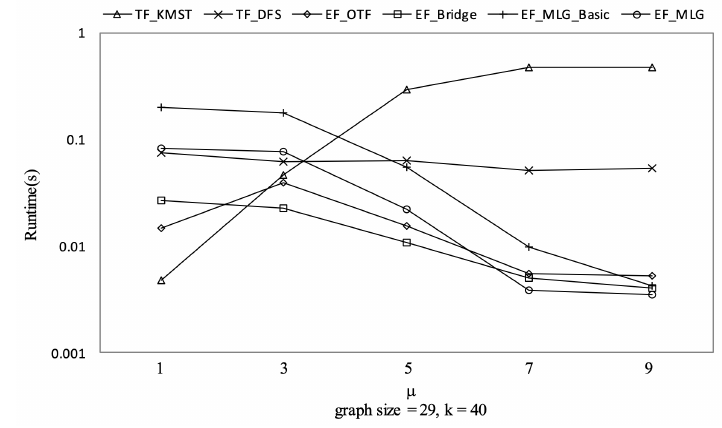
Figure 27. Runtime on Ncfu vs. µ with graphsize = 29 and k =